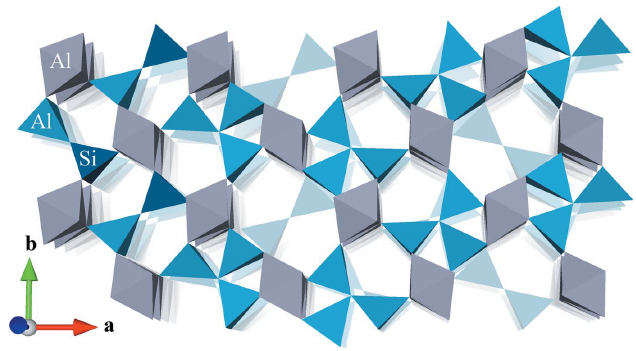
Figure 1 A model of the main structural elements of mullite. Chains of AlO 6 octahedra along the c axis are interconnected via a network of dicluster and tricluster tetrahedra, which also form chains along the c axis. The Al/ Si ratio determines the concentration of vacancies which in turn determines the concentration of triclusters, as each vacancy has a characteristic environment of two triclusters. Subsequent AB layers are shown with decreasing opacity to indicate that the vacancies do not form channels but are completely enclosed by the network of tetrahedra. In this model, below each vacancy there is a dicluster that consists of two Si